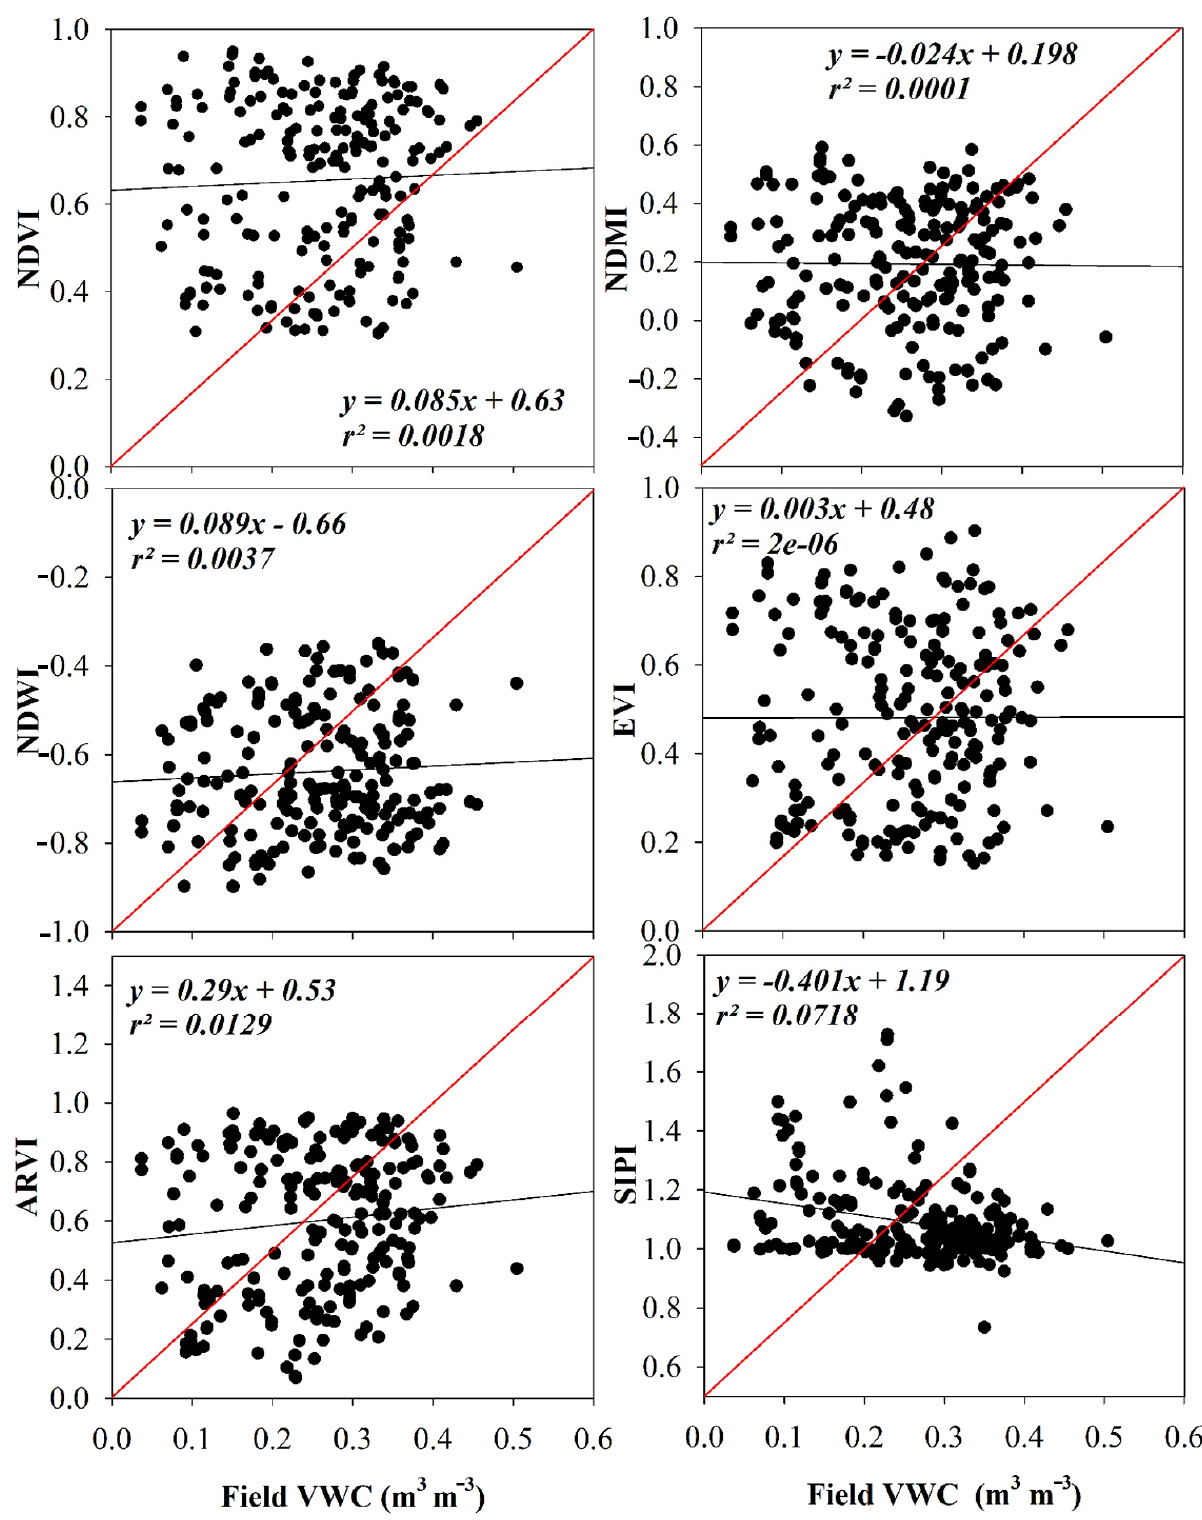
Figure 4. Scatter plot showing observed field VWC (m 3 m − 3 ) versus moisture-related indices (NDVI, NDMI, NDWI, EVI, ARVI, SIPI) for 2019 growing season in the RRVN using Landsat 8 images along with regression coefficient (r 2 ) and linear equation.